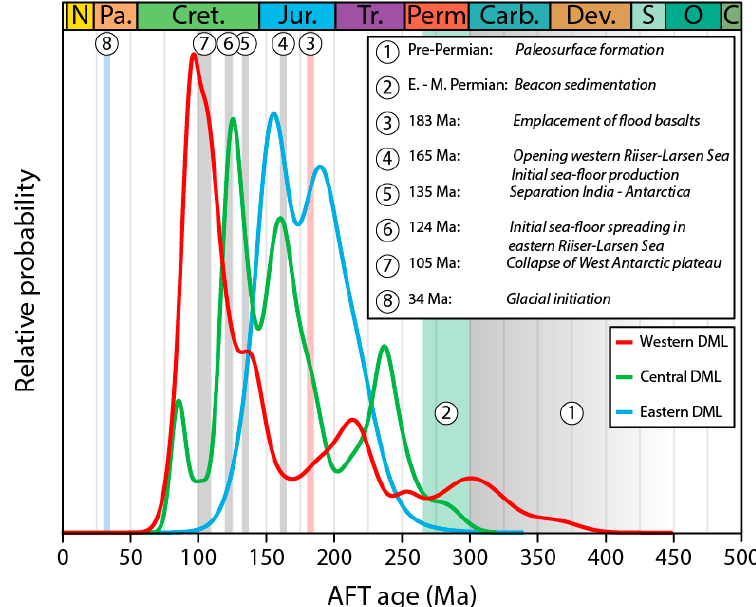
Figure 9. Probability density plot generated from available apatite fission track central ages from Dronning Maud Land. The time range of the main events that potentially affected the region are indicated in the background. The AFT ages from western Dronning Maud Land (DML) include data from Jacobs and Lisker [11], Emmel et al. [12] and Sirevaag et al. [14]. AFT ages from central Dronning Maud Land include the data from the present study together with the data from Emmel et al. [10]. The AFT ages from eastern Dronning Maud Land are solely based on data from Krohne [13]. Timing of the different events are from Plumstead [38], Lindström [40,41], Isbell [45], Duncan et al. [50], Roeser et al. [62], Bialas et al. [67] and Ingólfsson [114].